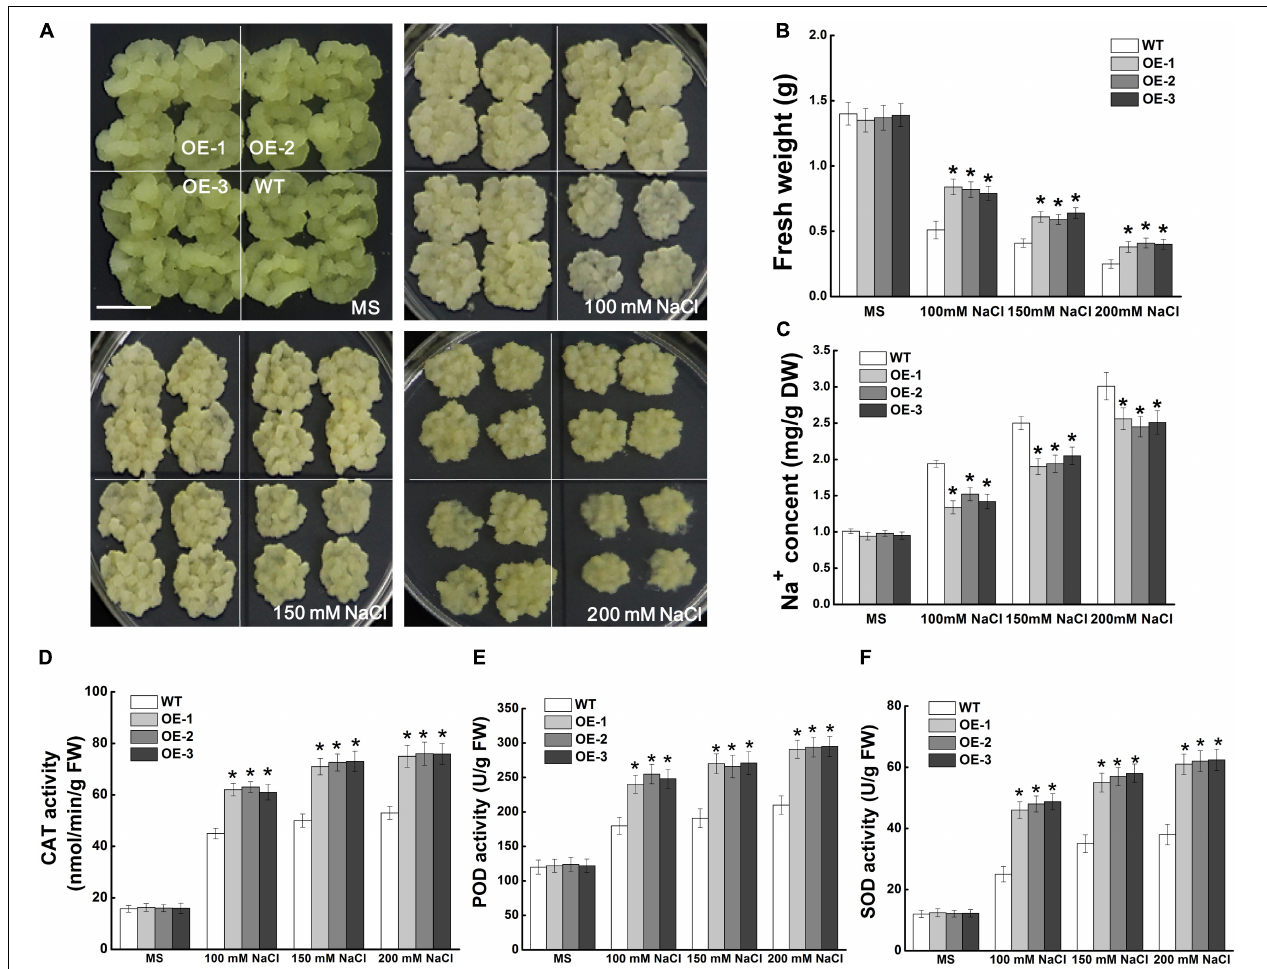
FIGURE 7 | Effects of NaCl treatment on the growth of wild type and MdCCX1 -overexpressing transgenic apple calli. Representative images (A) , fresh weight (B) , Na + content (C) , and activity of antioxidant enzymes (D–F) in WT and transgenic apple calli. The apple calli was cultured on MS medium supplemented with 0, 100, 150, and 200 mM NaCl for 15 d. Scale bars, 1 cm. For (B–F) , bars labeled with * in each panel indicate values that are significantly different form the WT at p < 0.05, using Student’s t-test